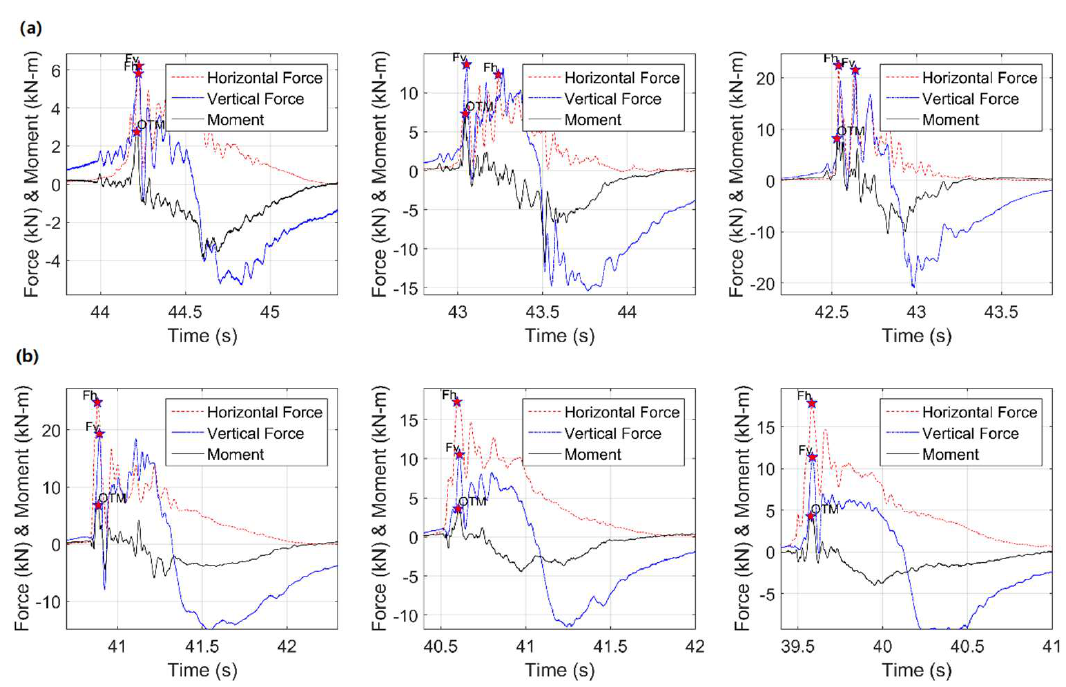
Figure 3. Wave-induced forces and moments for ( a ) solitary waves ( top ) with H = 0.42 m ( left ), H = 0.55 m ( center ), and H = 0.65 m ( right ); and ( b ) bores ( bottom ) with H = 0.90 m ( left ), H = 1.00 m ( center ), and H = 1.30 m ( right ).